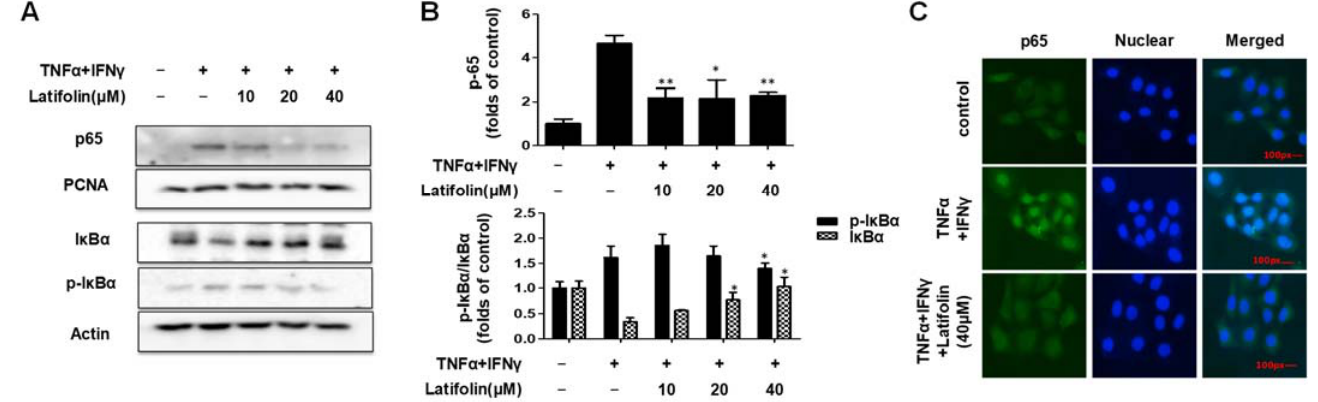
Figure 4. E ff ects of latifolin on NF- κ B signaling pathways in HaCaT cells ( A – C ). The data are expressed as the mean ± SD ( n = 3). * p < 0.05, ** p < 0.01 vs. TNF- α /IFN- γ -treated group.